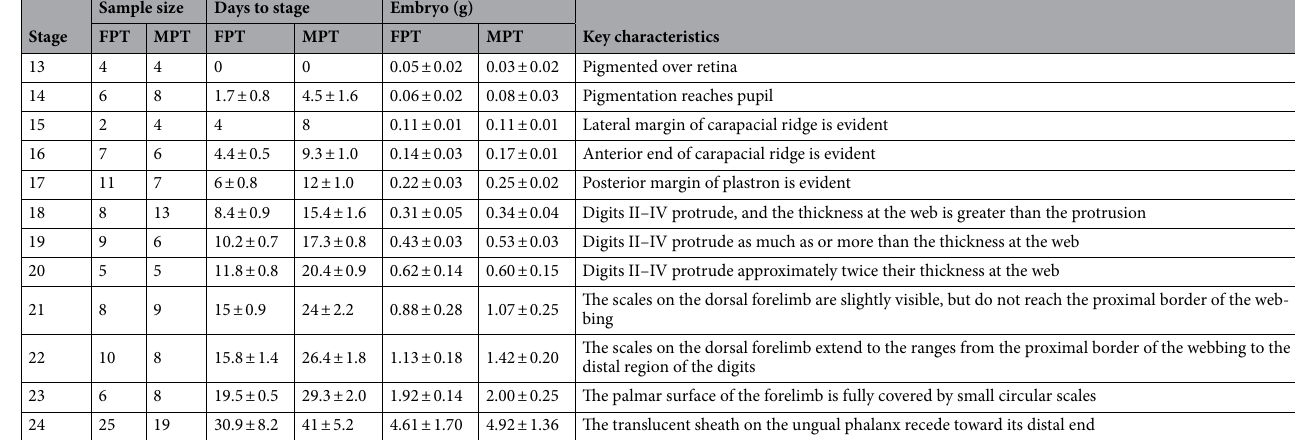
Table 1. The total sample size, days required to reach each stage from stage 13 (mean ± standard deviation, SD) at FPT or MPT, embryo weight at the time of dissection (mean ± SD), and the key characteristics used in this study for staging Mauremys reevesii . FPT and MPT denote female- and male-producing incubation temperatures (31 °C and 26 °C, respectively).